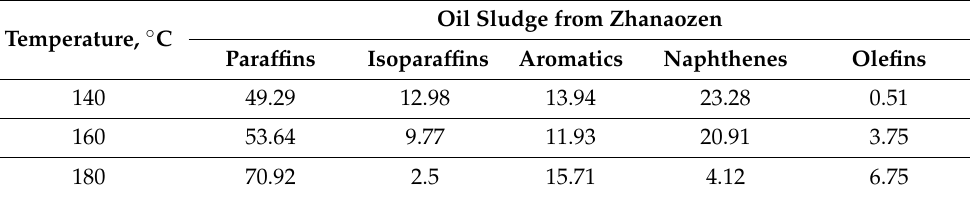
Table 4. Composition of light fraction isolated from Zhanaozen oil sludge depending on distillation temperature. Temperature, ◦ C